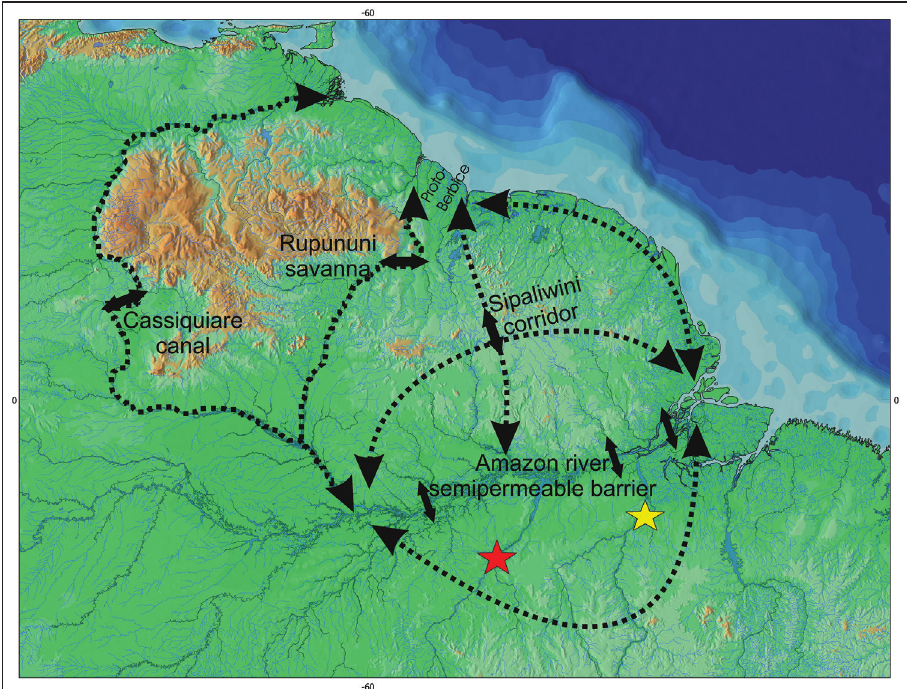
Figure 7. Hypothesized dispersal routs between basins of the Guiana Shield and Amazon Shield of ances- tror of the Pseudancistrus barbatus group (based on Lujan and Armbruster 2011). Our second hypothesis of the P. barbatus group extent-species distribution is based on the assumption of a widespread ancestral through all Guyana Shield rivers and dispersal events enable the ancestor of Pseudancistrus zawadzkii (red star) and Pseudancistrus sp. L17 (yellow star) to colonize the Amazon Brazilian Shield rivers in Tapajós and Xingu